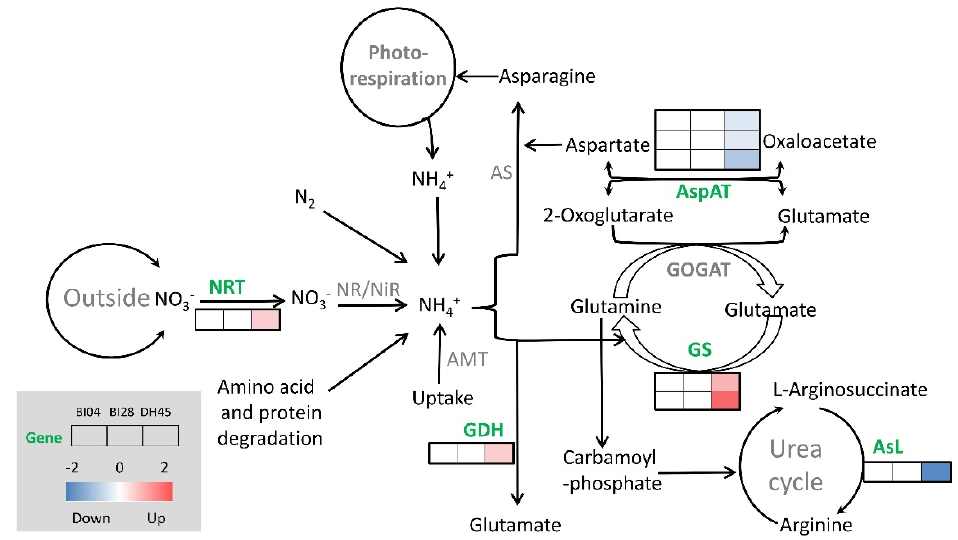
Figure 6. Schematic representing part of the nitrogen metabolism pathway. Relative expression levels of genes encoding specific enzymes between CK and LN treatments are shown in a color gradient from low (blue) to high (red). The columns for each heatmap are listed in order of BI04, BI28, and DH45.